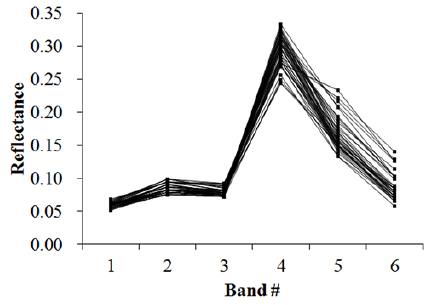
Figure 5. Spectral curves collected from samples used to determine Table 3. Identification template 1 for cropland class.